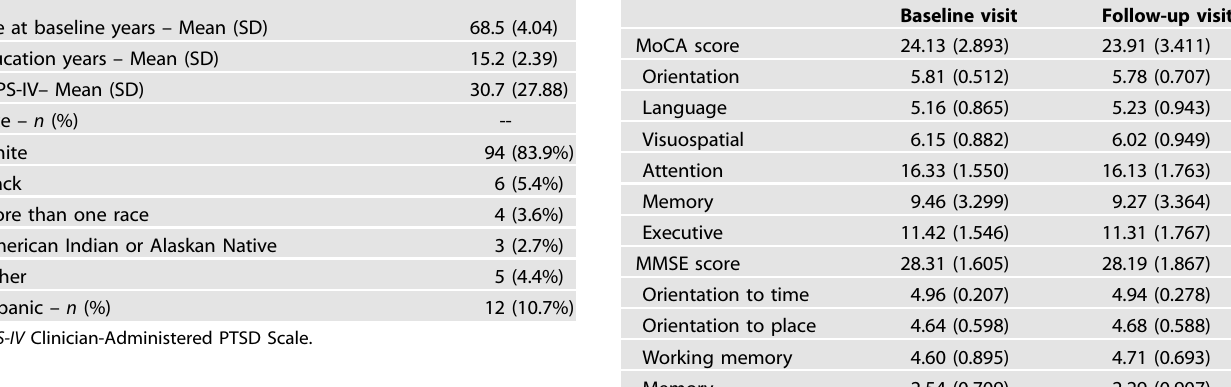
Table 1. Demographic characteristics ( N = 112; 100% male). Table 2. Cognitive characteristics ( N = 112; 100%